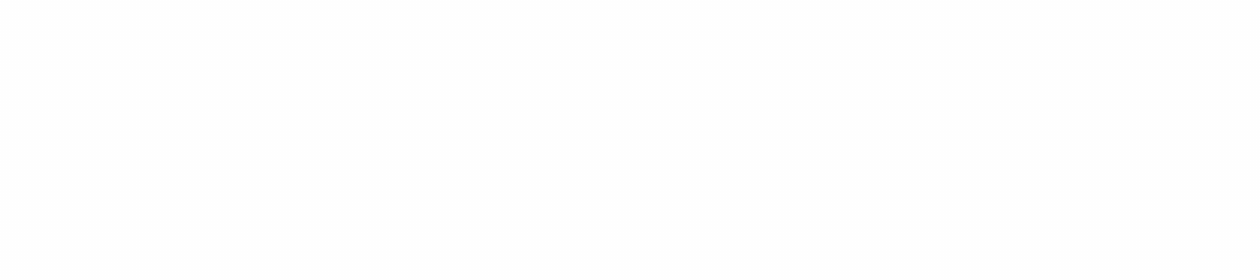
toxin-triggered autoimmune diabetes does not only correlate with the level of IFN-T production, but may be also manipulated by in vivo administration of this